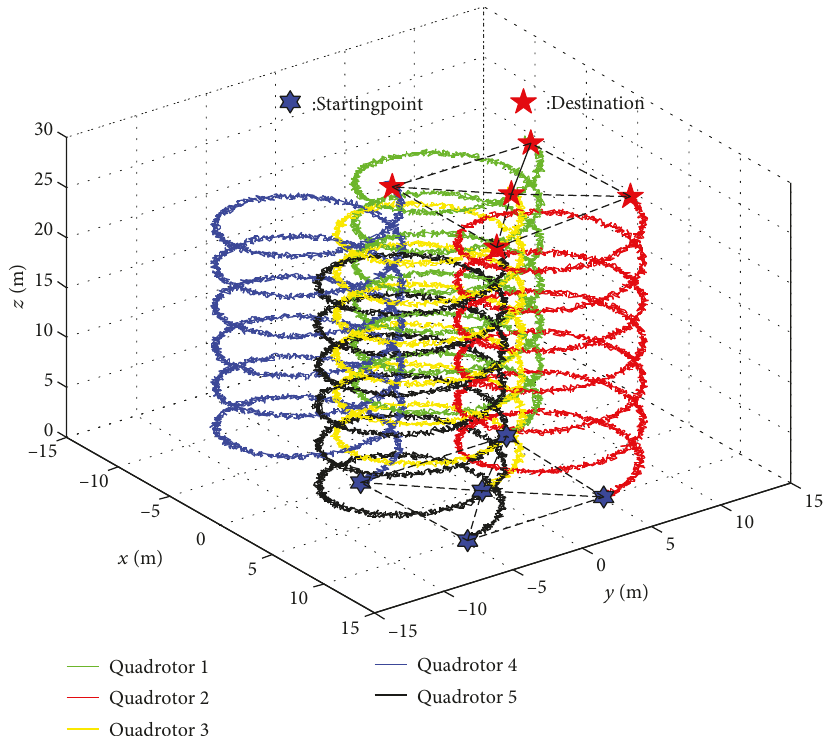
Figure 12: 3-D performance of formation fl